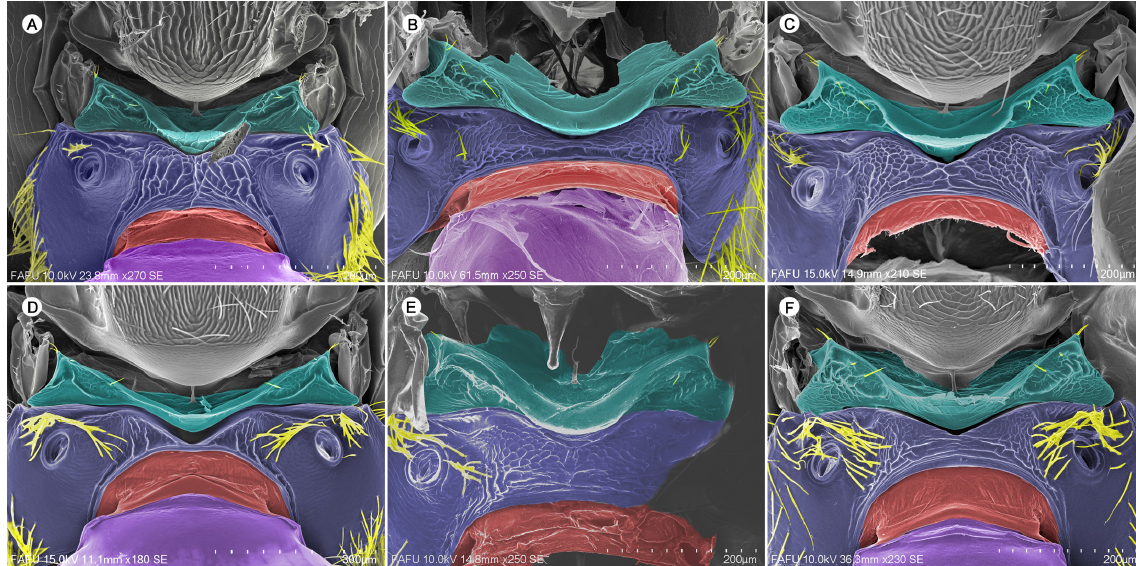
Fig. 10. SEM photos of dorsellum and propodeum. A . Zaischnopsis covid Jiang & Peng sp. nov. B . Z . fuscolivida Tang & Peng sp. nov. C . Z . lii Jiang & Peng sp. nov. D . Z . pacis Jiang & Peng sp. nov.